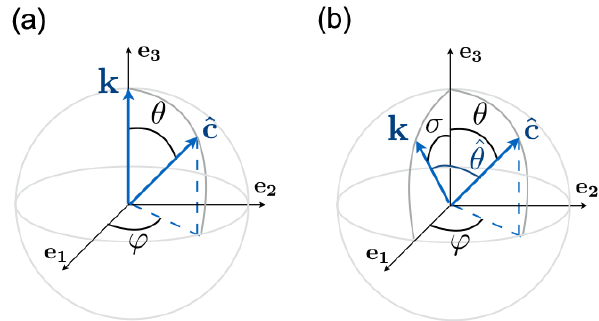
Figure 5. (a) System of angles used in Bennett’s calculations. ˆ c is given by ( ϕ , θ ) and k is given by σ , being otherwise in the ( e 1 , e 3 ) plane. The extra angle ˆ θ denotes the angle between k and ˆ c , thus cos ˆ θ = sin σ cos ϕ sin θ + cos σ cos θ . (b) Particular case of the Bennett configuration, for σ = 0; in this case, ˆ θ = θ